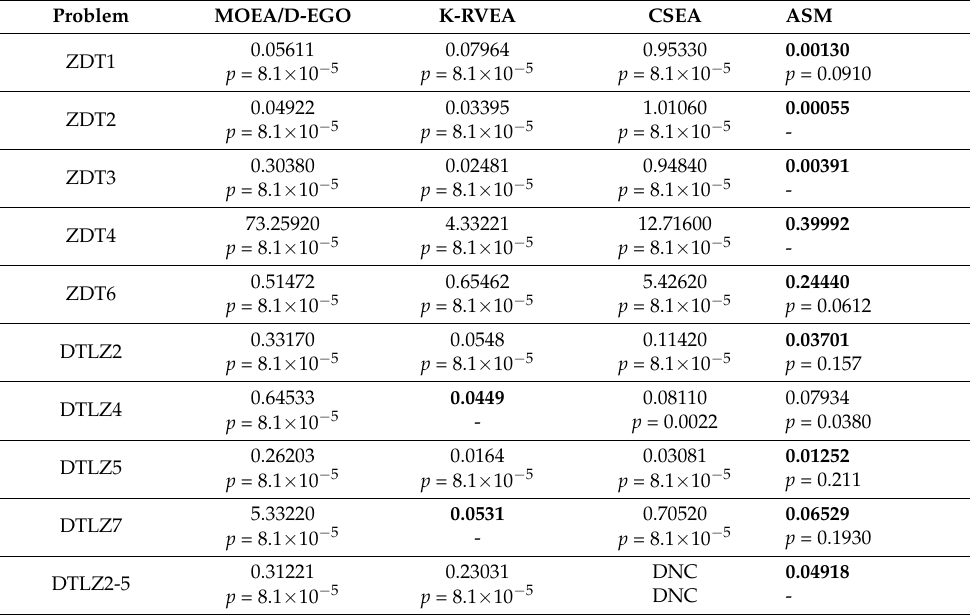
Table 5. Median IGD on unconstrained problems using ASM approach, and MOEA/D-EGO, K- RVEA, and CSEA algorithms. DNC is denoted as “Did not converge” within given